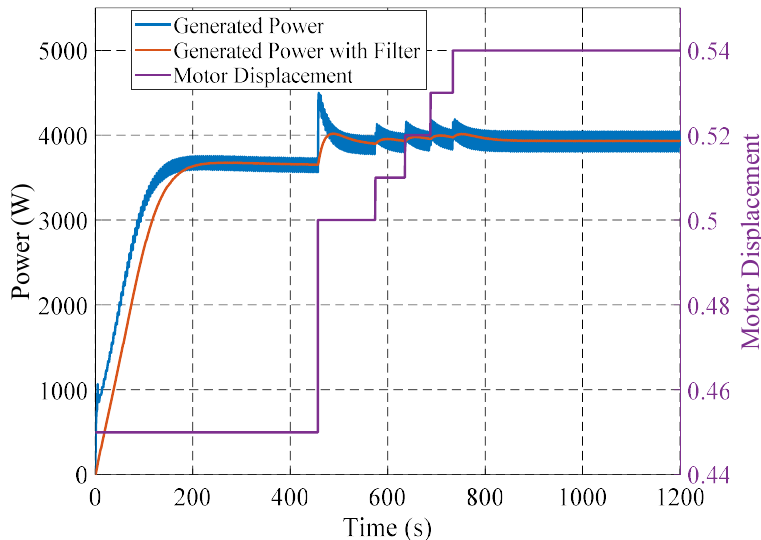
Figure 19. The generated power and the ratio of motor displacement under the MPPT control.